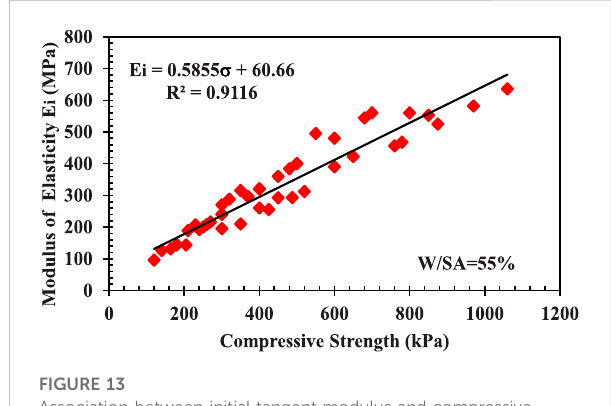
FIGURE 13 Association between initial tangent modulus and compressive strength.